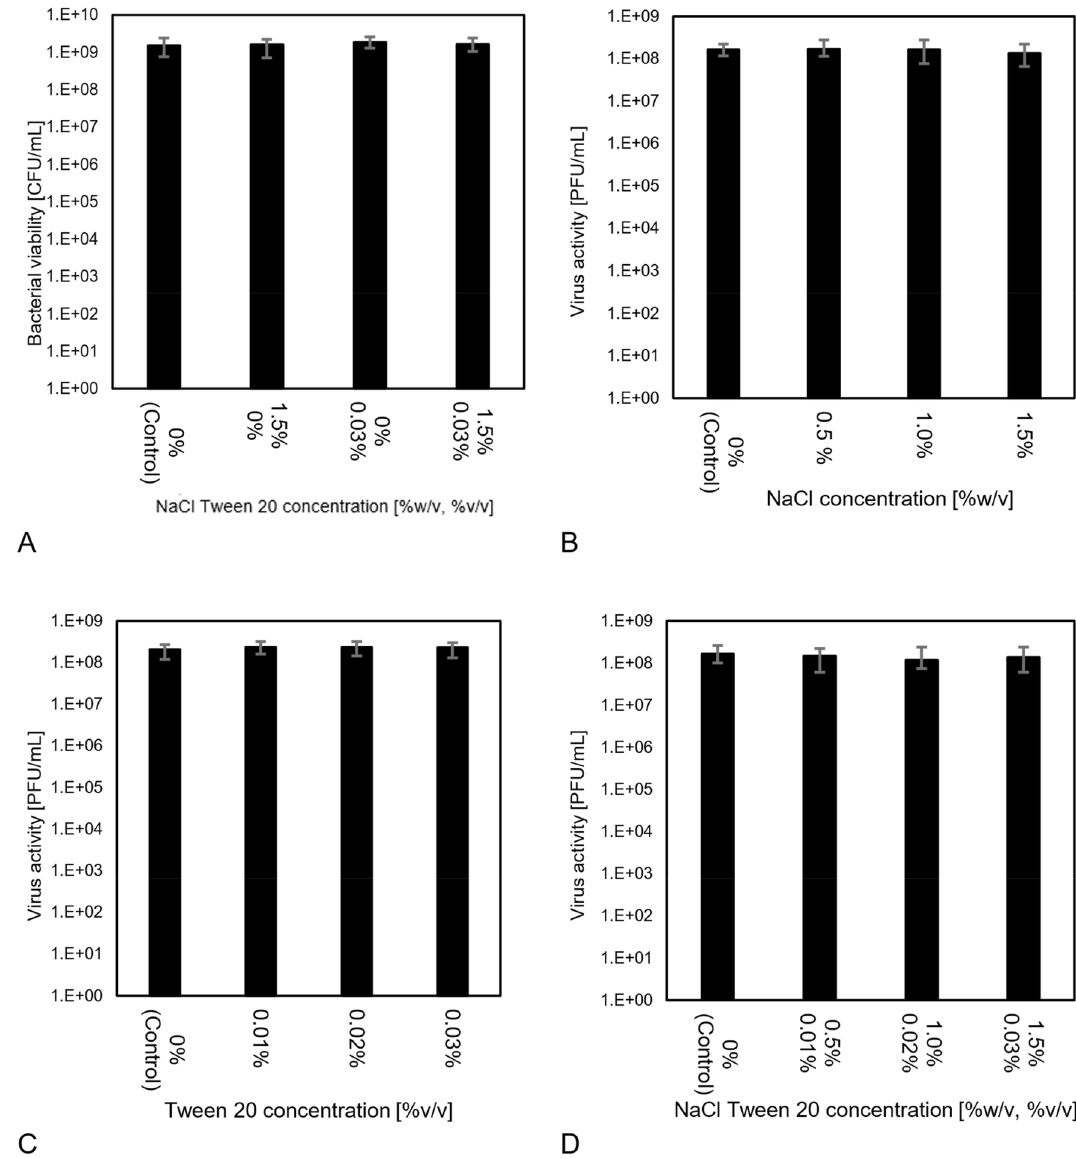
Figure 4. Verification of Phi6 and bacterial stability in the virus extraction solution consisting of King Broth (KB) and active ingredients that would be washed from sample filters during extraction. ( A ) Bacterial viability in washing solution containing 0% to 1.5% w/v NaCl and 0% to 0.03% v/v Tween 20; ( B ) Viral stability in washing solution containing 0% to 1.5% w/v NaCl. ( C ) Viral stability in washing solution containing 0% to 0.03% v/v Tween 20; ( D ) Viral stability in washing solution containing 0% to 1.5% w/v NaCl and 0% to 0.03% v/v Tween